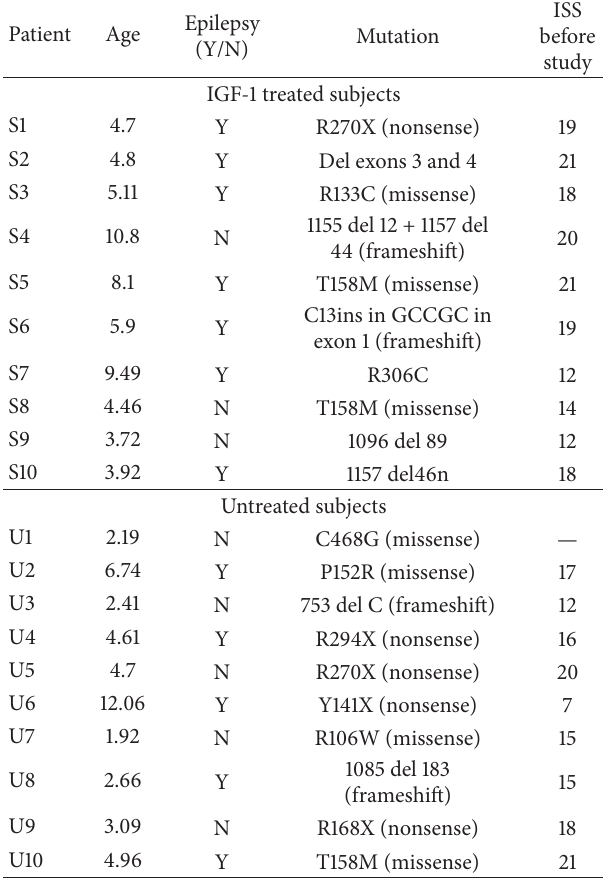
Table 1: Patients included in the present study. Table 2: Positive and negative features of the novel Rett Severity Score